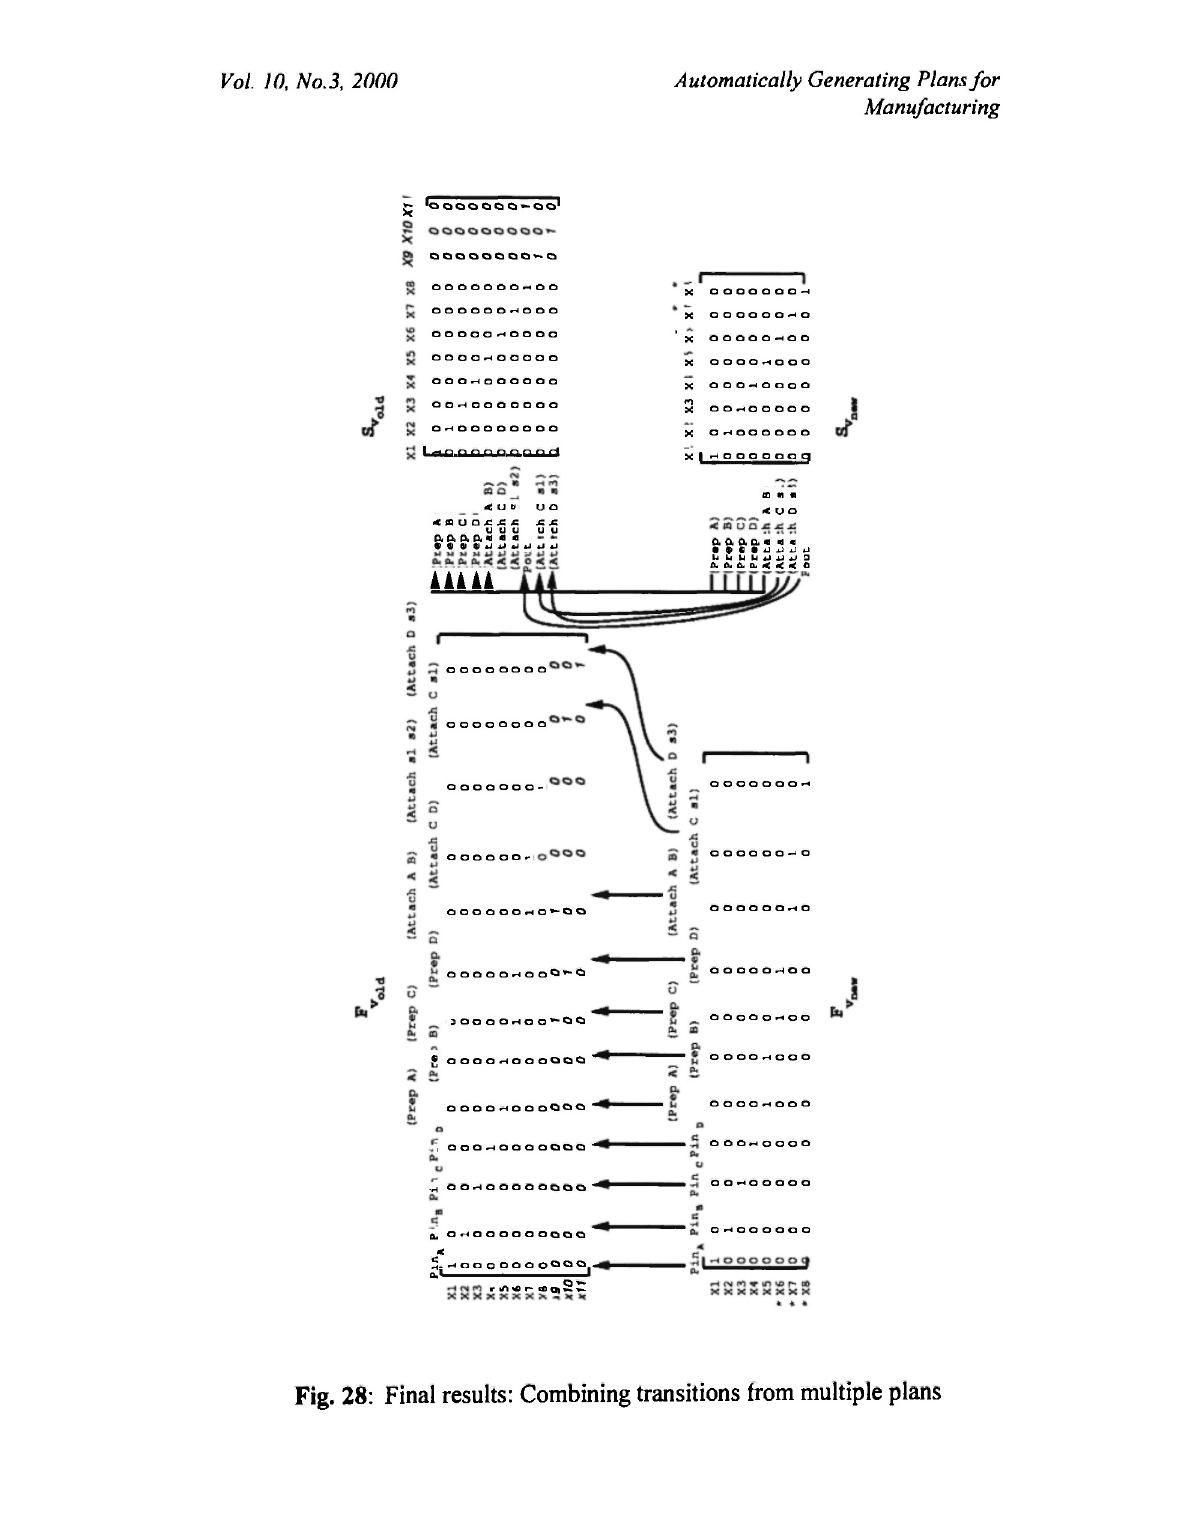
Fig. 28: Final results: Combining transitions from multiple plans